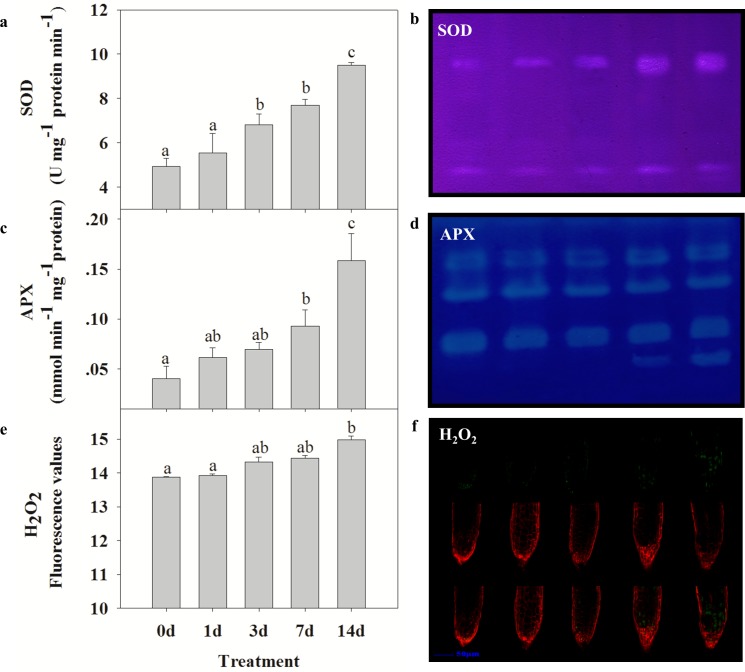
Effects of drought stress on antioxidant enzymes and H2O2 accumulation in S. purpurea seedlings.(A, C) Effects of different RWCs on SOD and APX activities in S. purpurea seedlings, as determined by a colorimetric method. (B, D) Effects of drought on SOD and APX activities as determined by activity staining. (E) H2O2 formation, as visualized by infiltrating H2DCF-DA into roots of S. purpurea and observing fluorescence. (F) Average fluorescence intensity of H2O2. Data are mean values ± SE obtained from three independent experiments (n = 30). Different letters within a column indicate significant differences (p<0.05; one-way analysis of variance and Tukey’s test.). Bar = 50 μm.